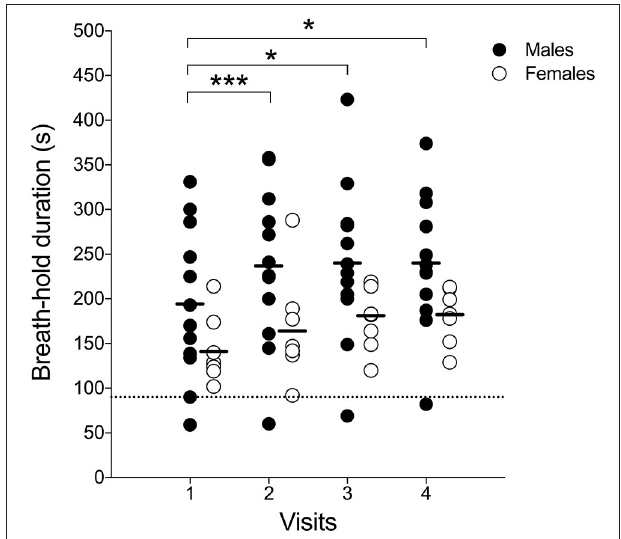
FIGURE 5 | Individual subject’s maximal-enhanced deep-inspiration breath hold (eDIBH) duration; black line: group average, dashed line: 90s duration. * p < 0.01; *** p < 0.001.